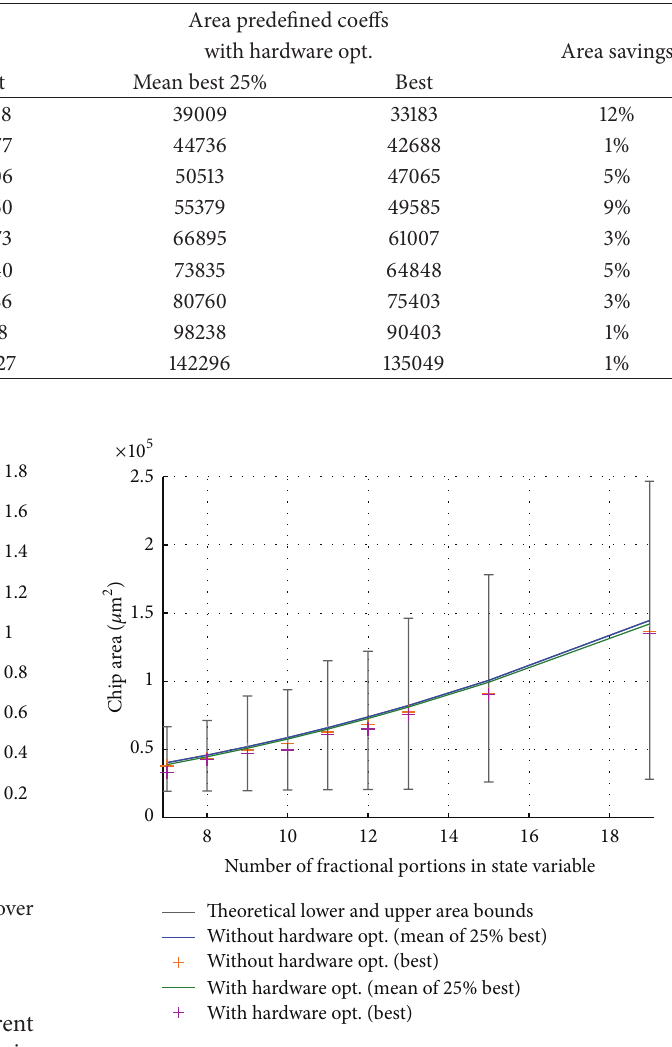
Figure 14: Chip area for predefined coefficients with and without multiobjective optimisation for hardware efficiency (fixed-point) as presented in Table 5. Limit bars indicate the theoretical minimum and maximum area